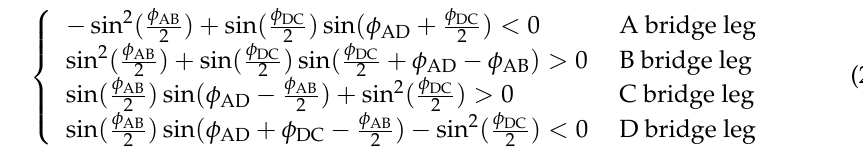
Figure 7. ZVS area under DPS modulation. According to Figure 5, the conditions for realizing ZVS of the full-bridge arm in TPS modulation mode can be obtained, as shown in Equation (21):